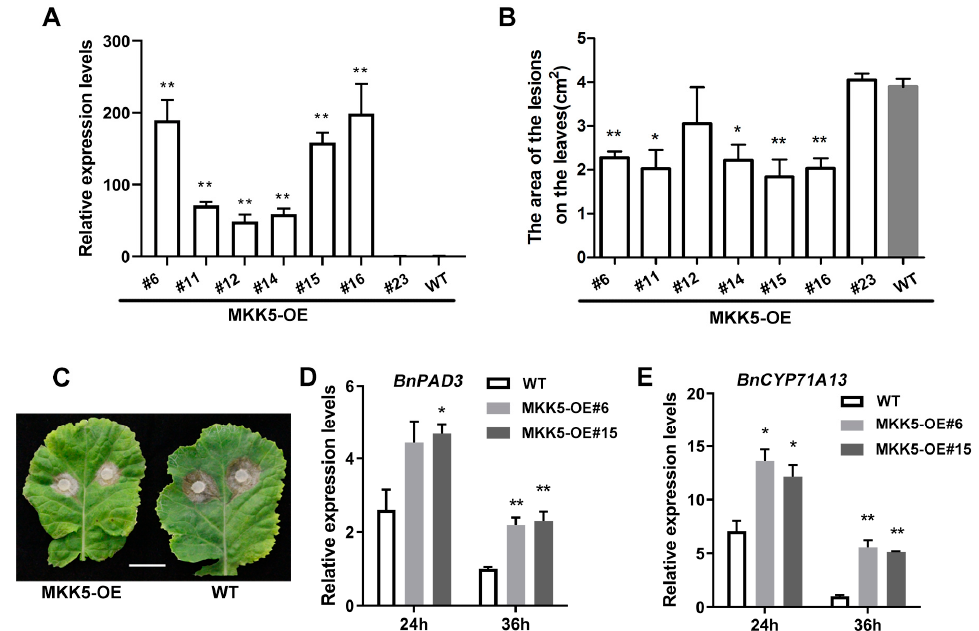
Figure 2. Overexpression of BnaA03.MKK5 enhances S. sclerotiorum resistance in B. napus. ( A ) qRT-PCR analysis of BnaA03.MKK5 overexpression (MKK5-OE) lines. The expression in wild-type (WT) plants is used as the control. ( B , C ) Statistical analysis of lesion areas of MKK5-OE lines after 48 h of inoculation, and lesion imaging of representative lines. Scale bar, 2 cm. ( D , E ) Relative expression levels of BnPAD3 and BnCYP71A13 in MKK5-OE lines and WT plants after inoculation for 24 h and 36 h. In all charts, data are shown as means ± SD ( n = 3). Asterisks indicate significant differences compared with WT plants at corresponding time points ( t -test, * p < 0.05, ** p <